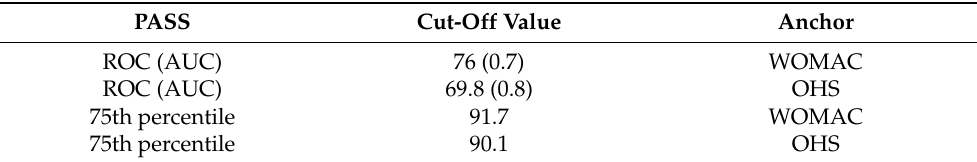
Table 2. Patient acceptable symptom state (PASS) for FJS-12 calculated by both distribution-based and anchor approaches. PASS Cut-Off Value Anchor ROC (AUC) 76 (0.7) WOMAC ROC (AUC) 69.8 (0.8) OHS 75th percentile 91.7 WOMAC 75th percentile 90.1